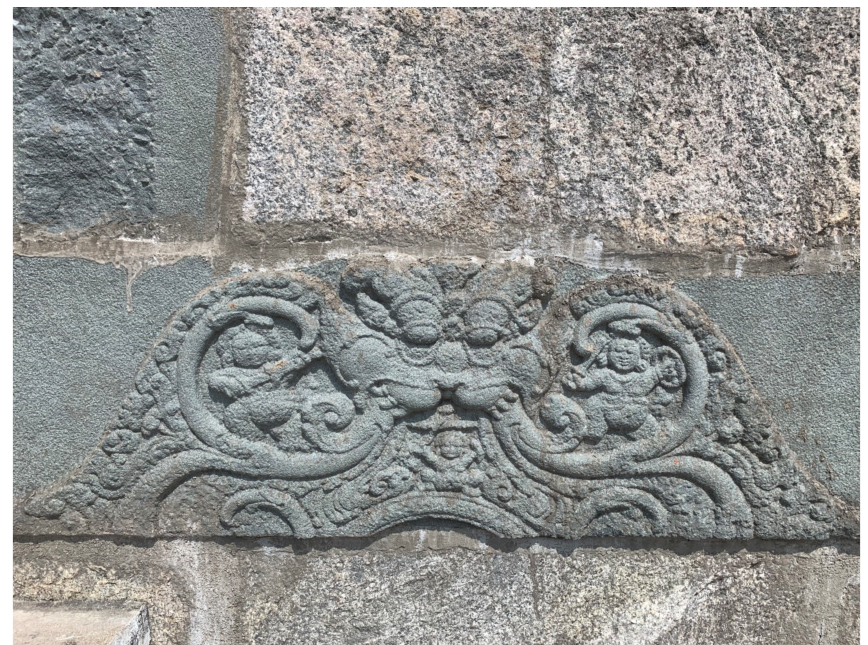
Figure 13. Architectural reuse, K ō ṭṭ ai Perum ā ḷ temple, Kaveripakkam, Tamil Nadu. Photograph by Emma Natalya Stein.